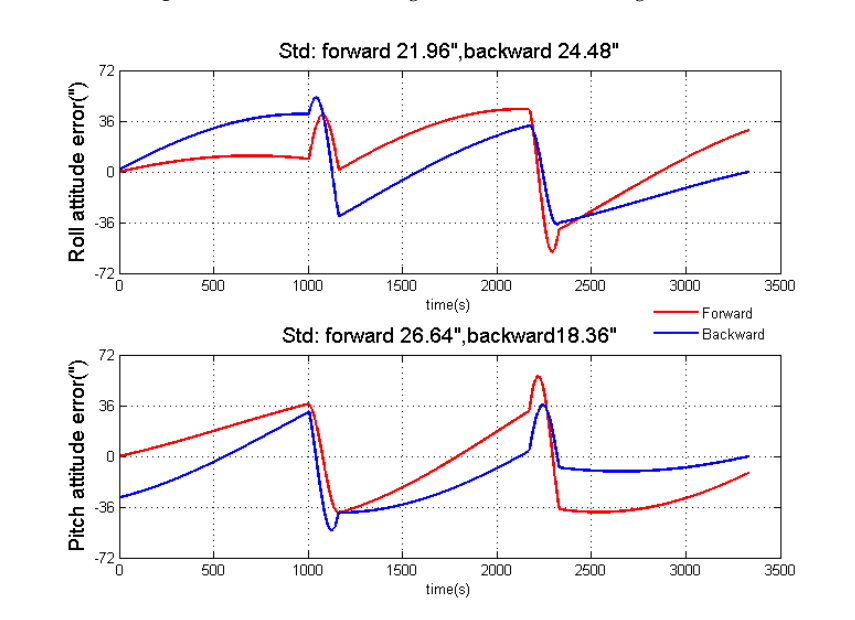
Figure 5. Standalone inertial navigation results after adding